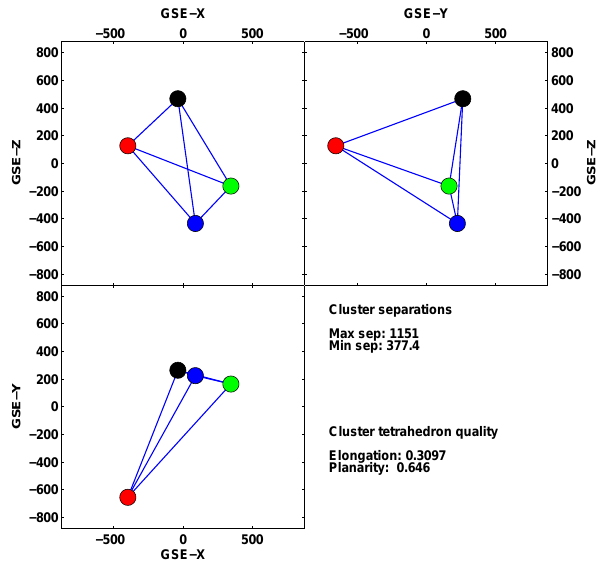
Fig. 5. Configuration of the Cluster tetrahedron during the shock crossing that occurred on 5 April 2001 at 20:24